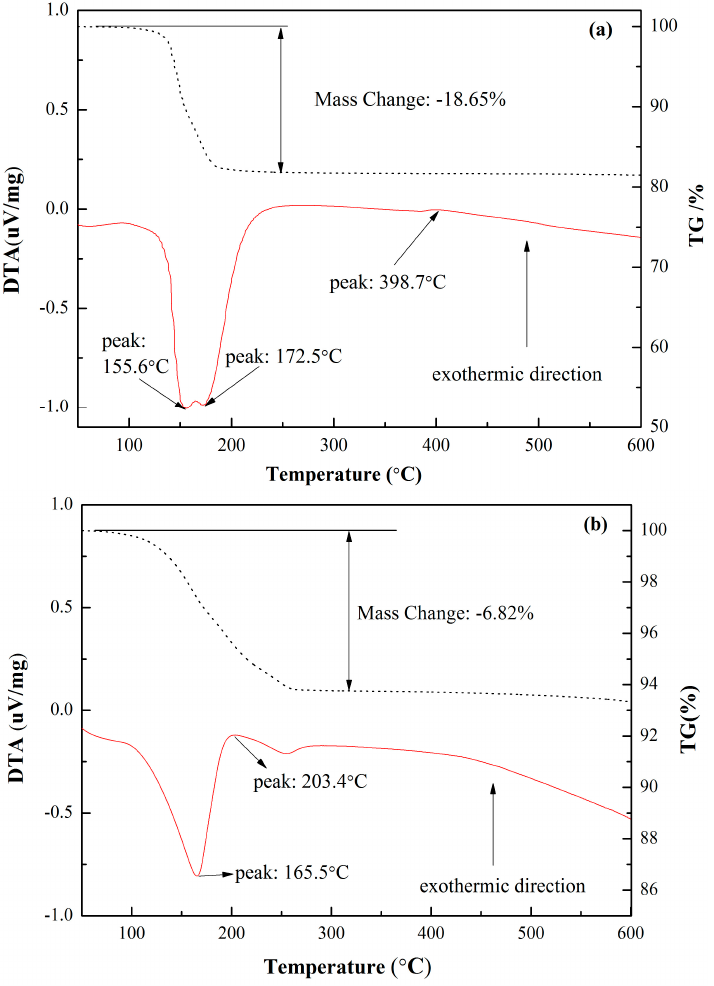
Figure 3. TG-DTA pattern of ( a ) FGD gypsum and ( b ) CSHW derived from FGD gypsum by the hydrothermal synthesis.